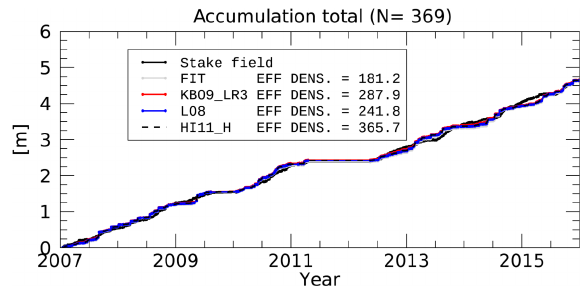
Figure 13. Total snowfall from CloudSat and stake field for all 369 weeks where data were available for both CloudSat and the stake